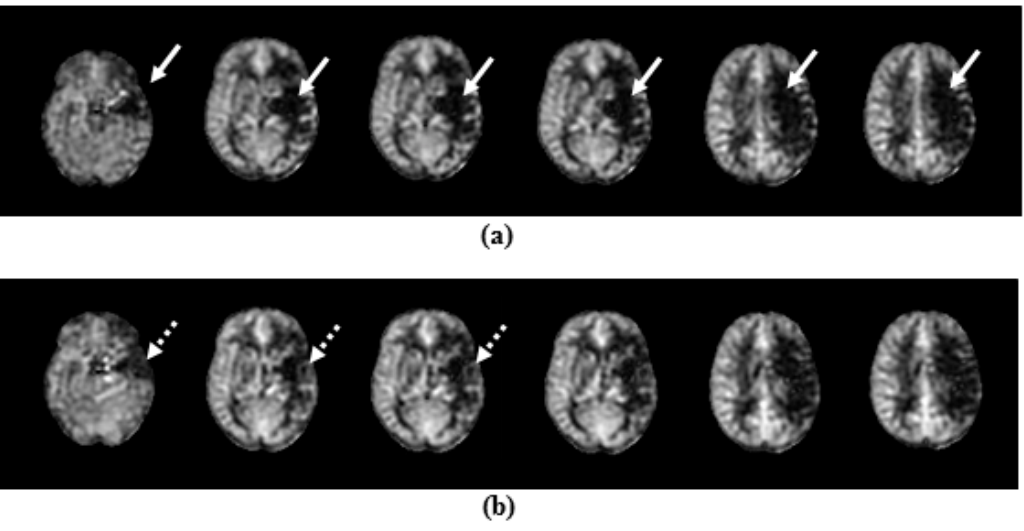
Figure 3. Representative Arterial Spin Labelling (ASL) dataset from a stroke patient at 2 weeks ( a ) and 12 weeks ( b ). A large area of reduced perfusion is seen at 12 weeks within the area affected by the stroke (solid arrows), but some regions within the affected area show a mild recovery of perfusion at 12 weeks (dashed arrows).